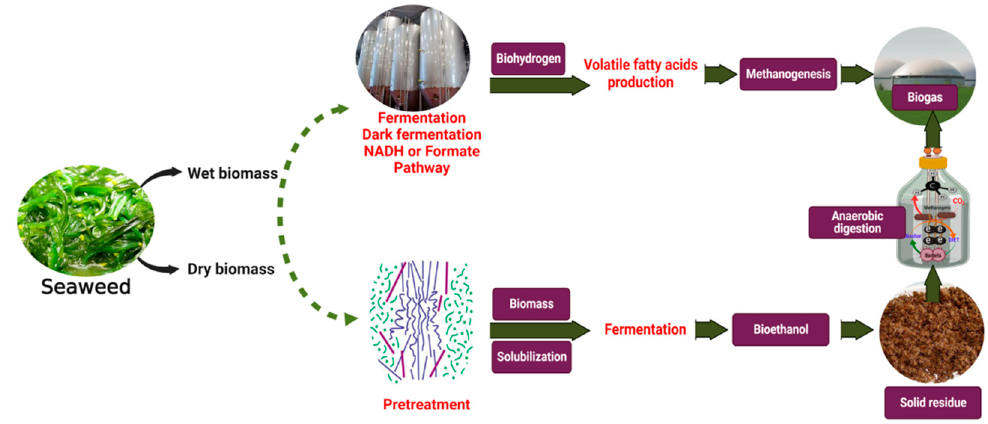
Figure 5. The principal of sequential energy recovery from seaweed. Table 5. Comparison of pre-treated microalgae, lignocellulosic biomass, and unpretreated seaweed biomethane potential.